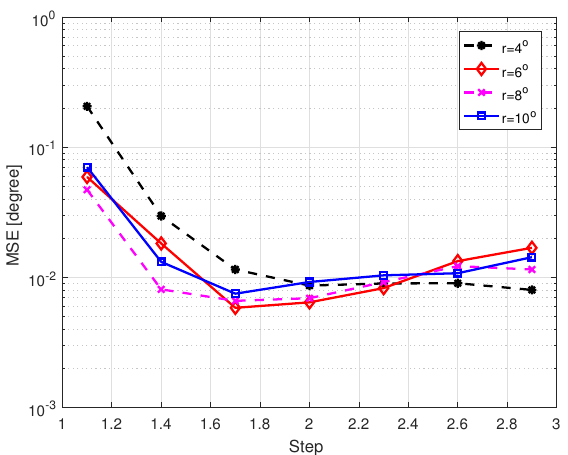
Figure 8. MSE of DOA estimation versus step with SNR = 10 dB.